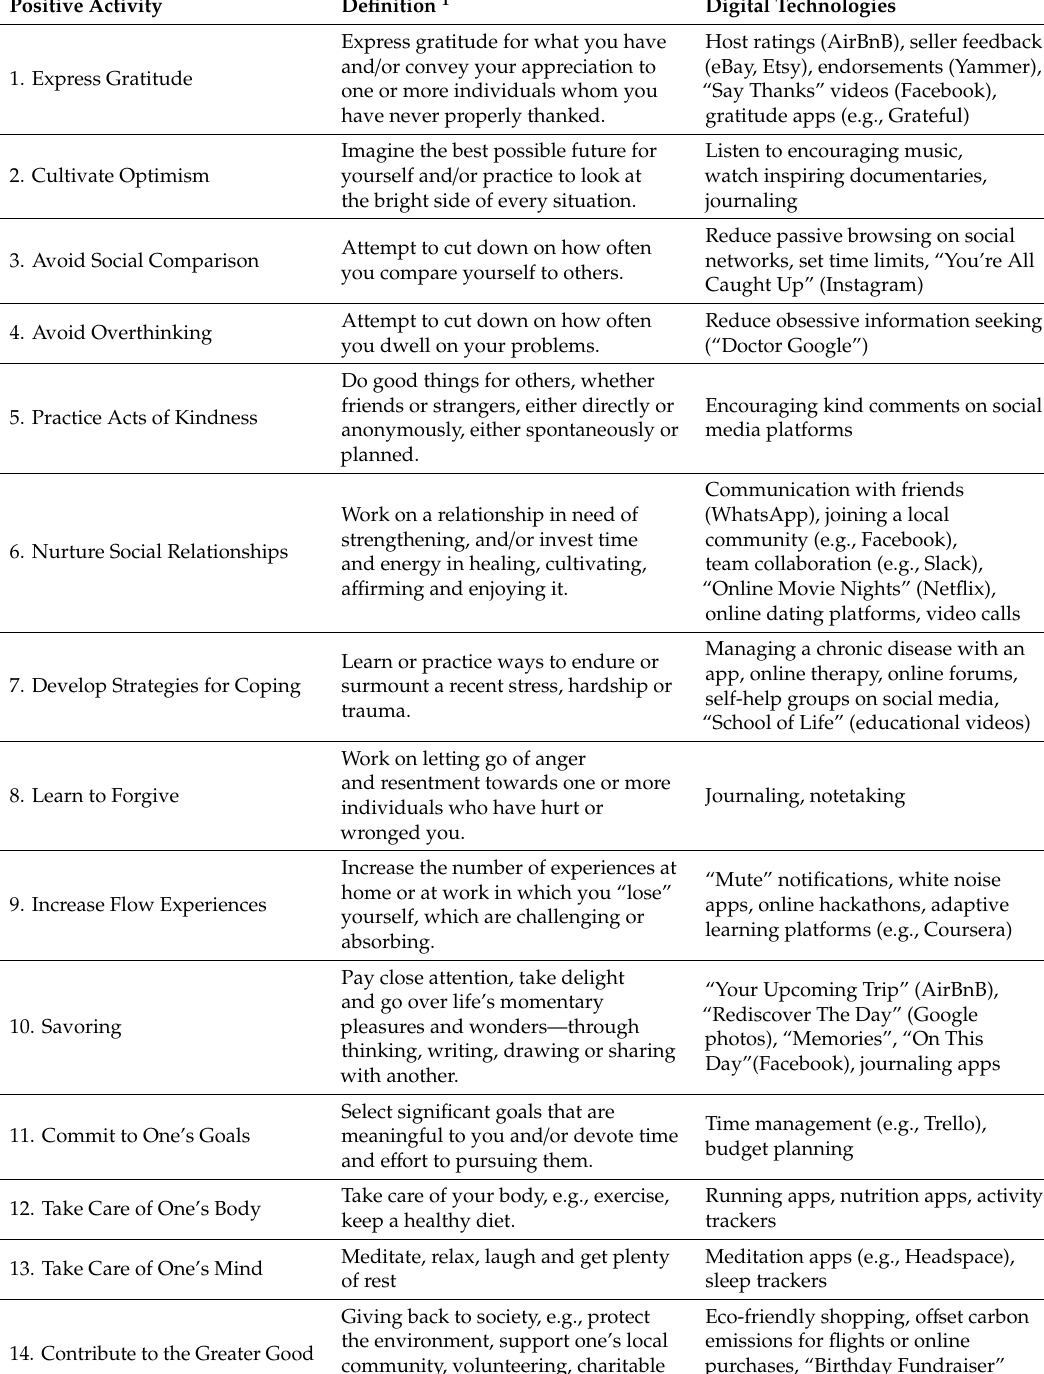
Table 1. Wellbeing-enhancing activities [3,21,22] supported by designed artefacts (including examples of digital